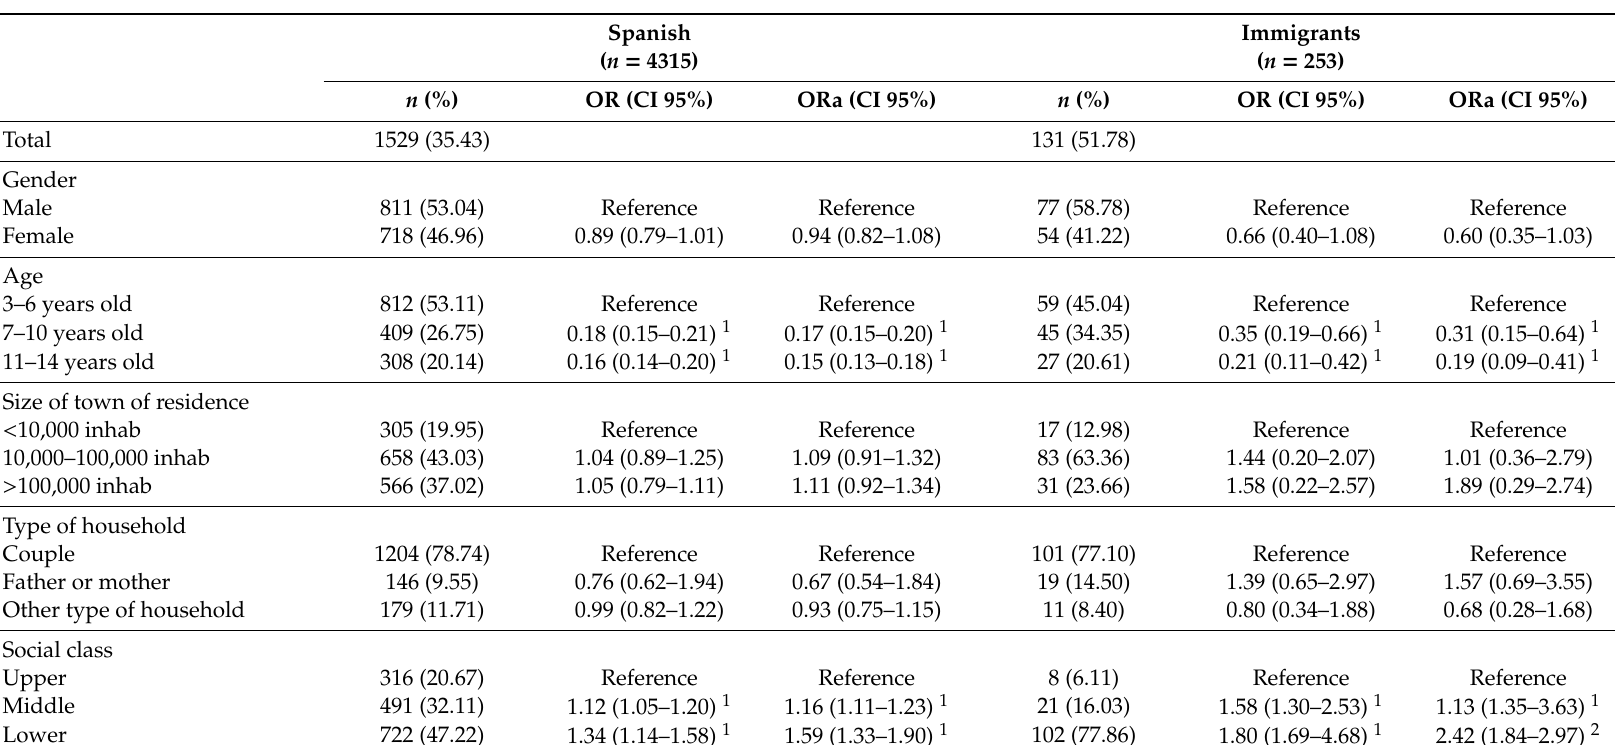
Table 2. Association between non-regular utilization of dental services and socioeconomic and demographic variables in Spanish and immigrant child-adolescent population. Spanish National Health Survey,